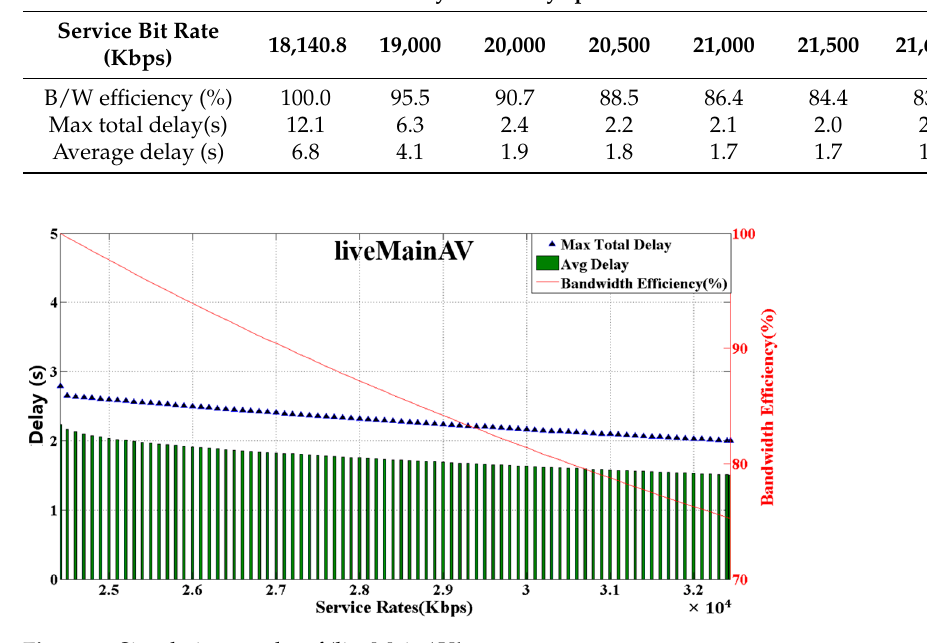
Figure 8. Simulation results of ‘liveMainAV’. Table 8. Simulation results of ‘liveMainAV’.